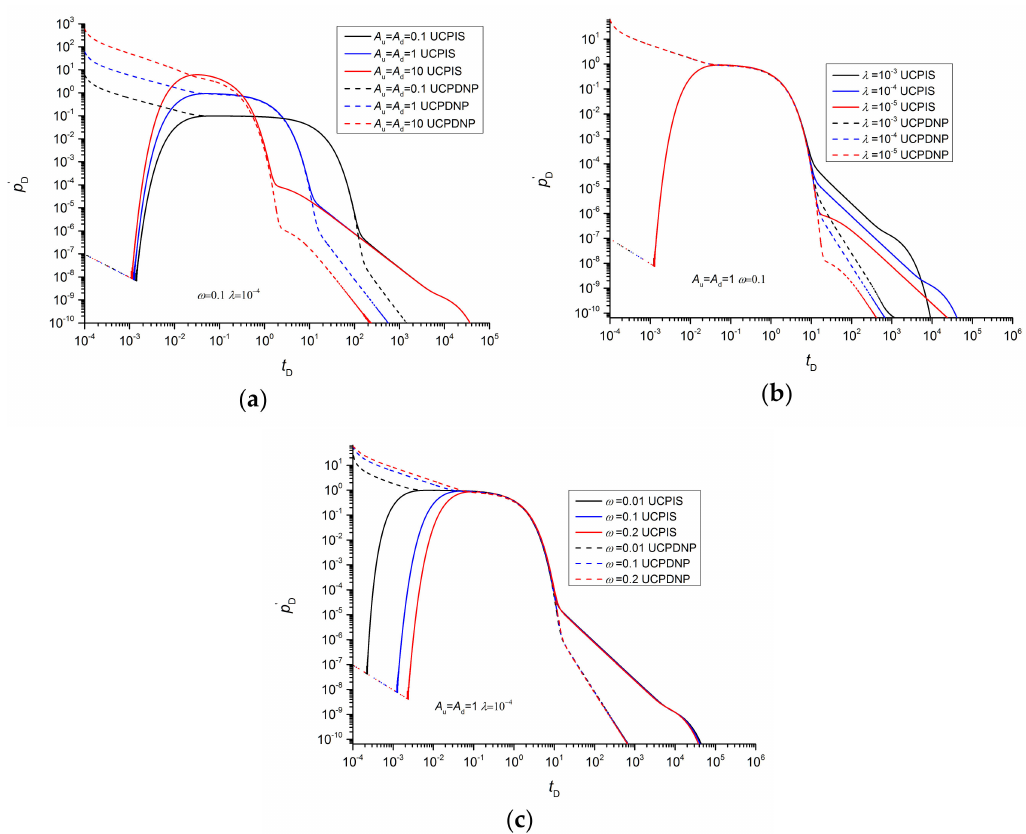
Figure 8. Comparison of pressure derivative curves between the UCPIS method and UCPDNP method: